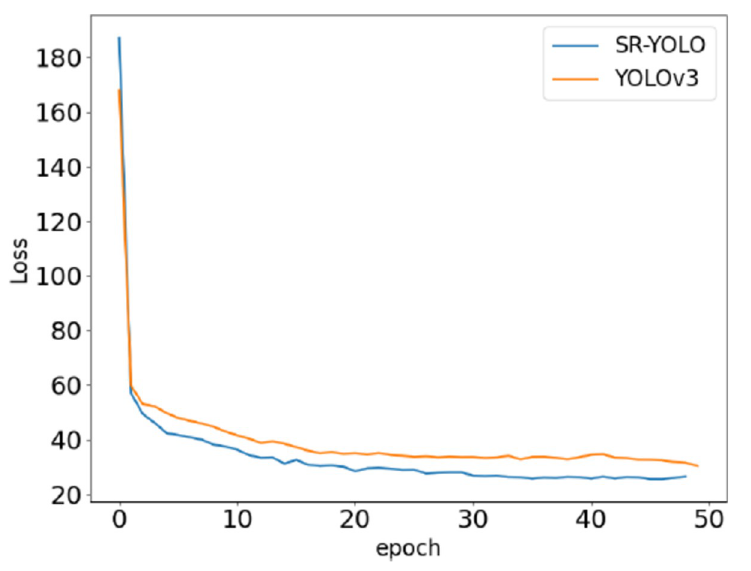
Fig 13. Training loss function graph.